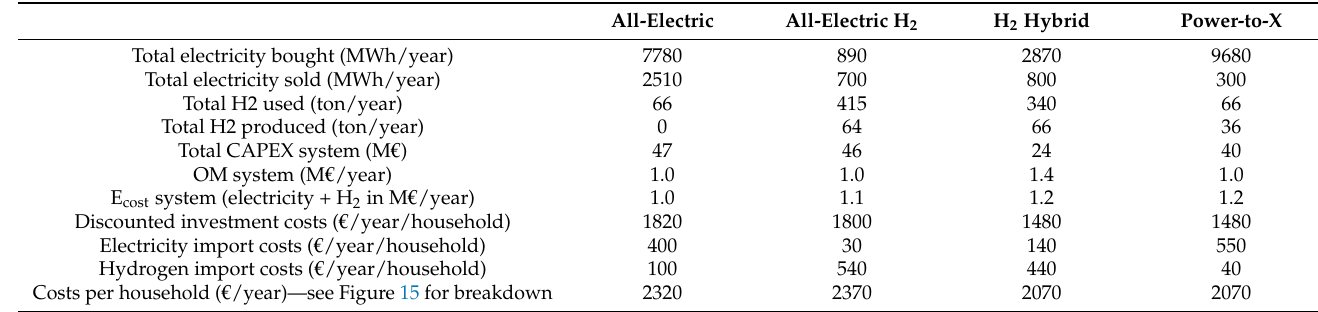
Table 8. Economic results of the four